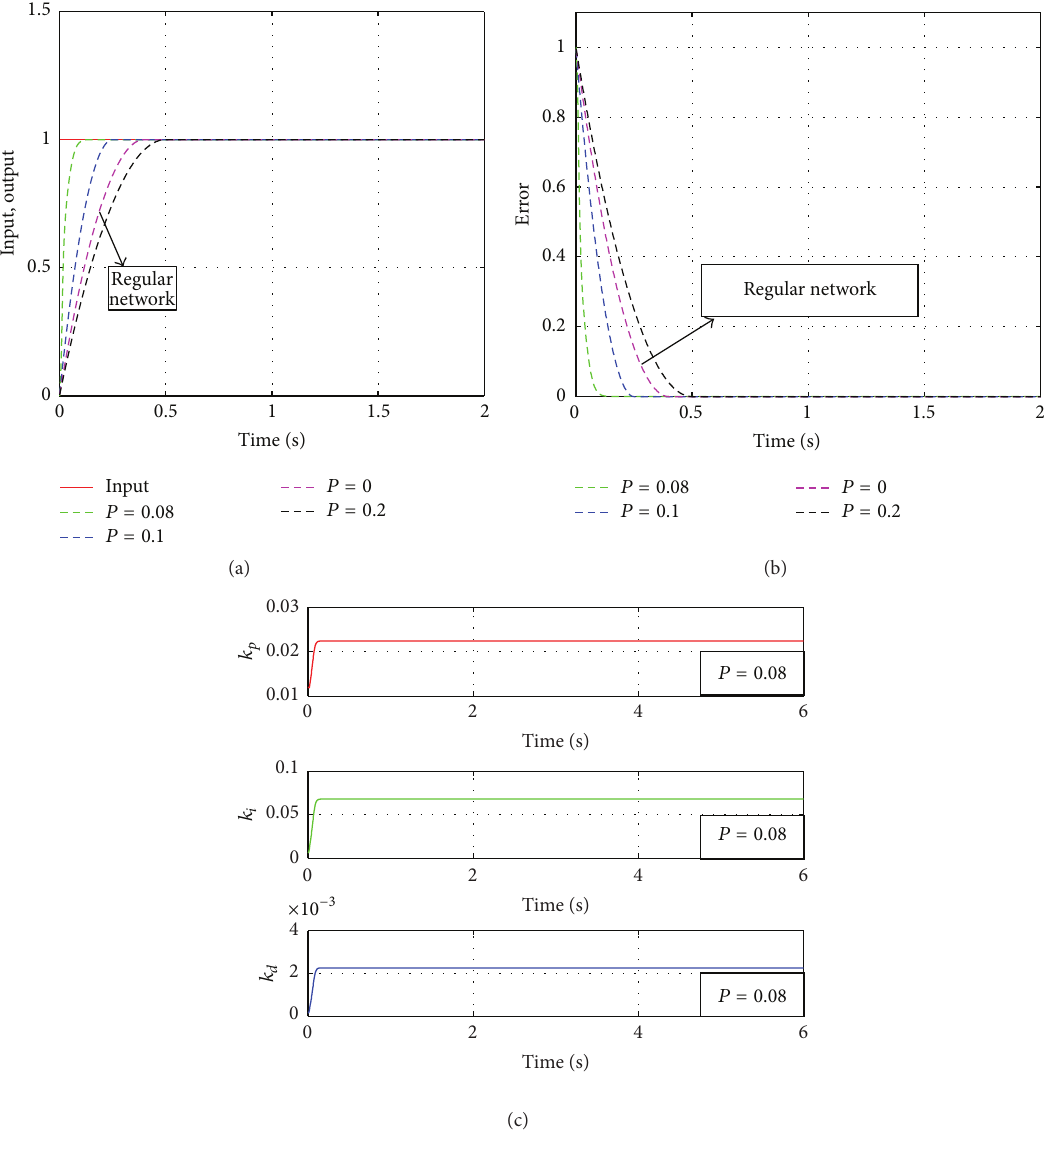
Figure 12: The simulation results of the memristive neural network PID controller (𝑟 The step response curve. (b) The error curves. (c) The curves of the control parameters when the rewiring probability 𝑃 = 0.08 .